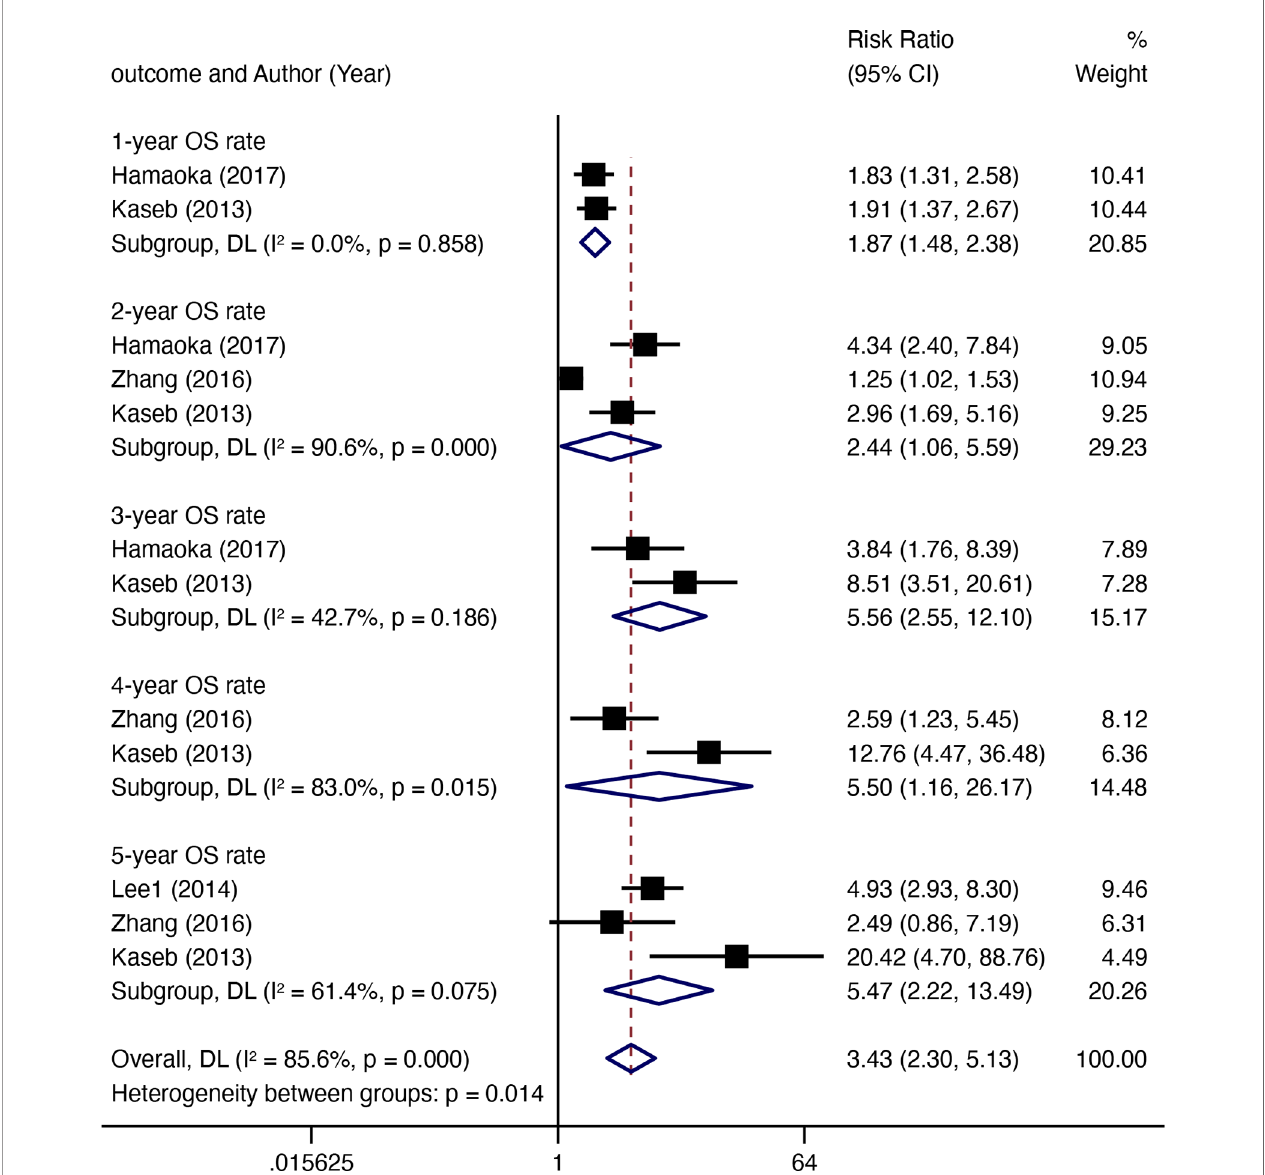
FIGURE 4 | The OS rate (resection after downstaging versus LRT or systematic treatment alone) for HR with downstaging therapies in patients with